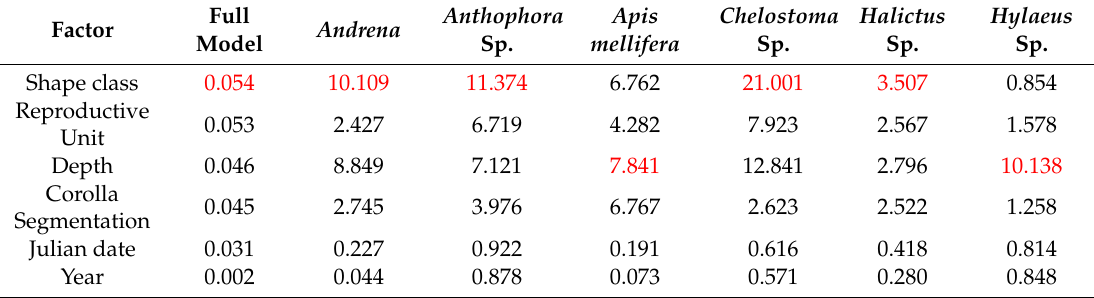
Table 4. Gini decrease importance estimates for the factors in the logistic regression. Symmetry was deleted from the model because it is strongly correlated with shape class. The variable of highest importance in each column is indicated in